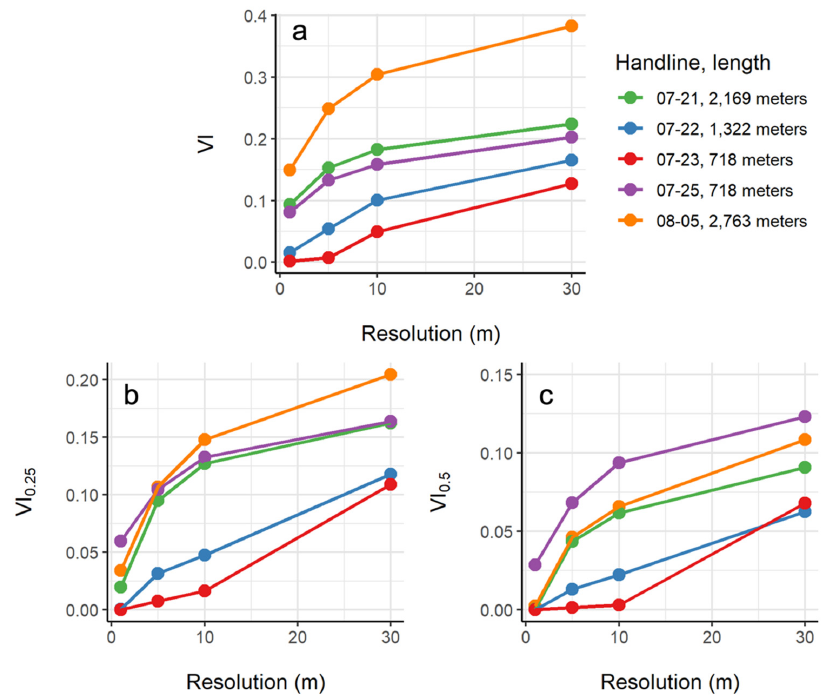
Figure 7. VI across resolutions. Connected points represent VI derived from lidar-based viewsheds for each handline. ( a ) VI, no threshold. ( b ) VI 0.25 , x = 25% threshold applied. ( c ) VI 0.5 , x = 50% threshold applied.